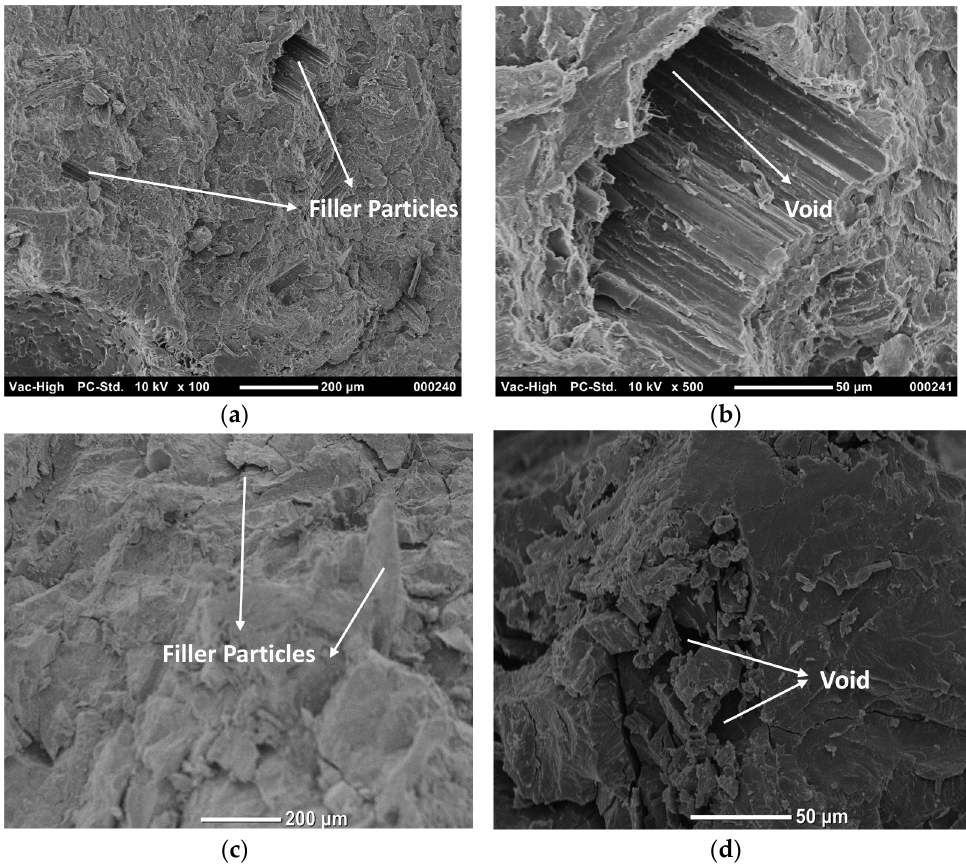
Figure 3. SEM of ( a , b ) PLA-UTDPWF, and ( c , d ) PLA-NaOH.